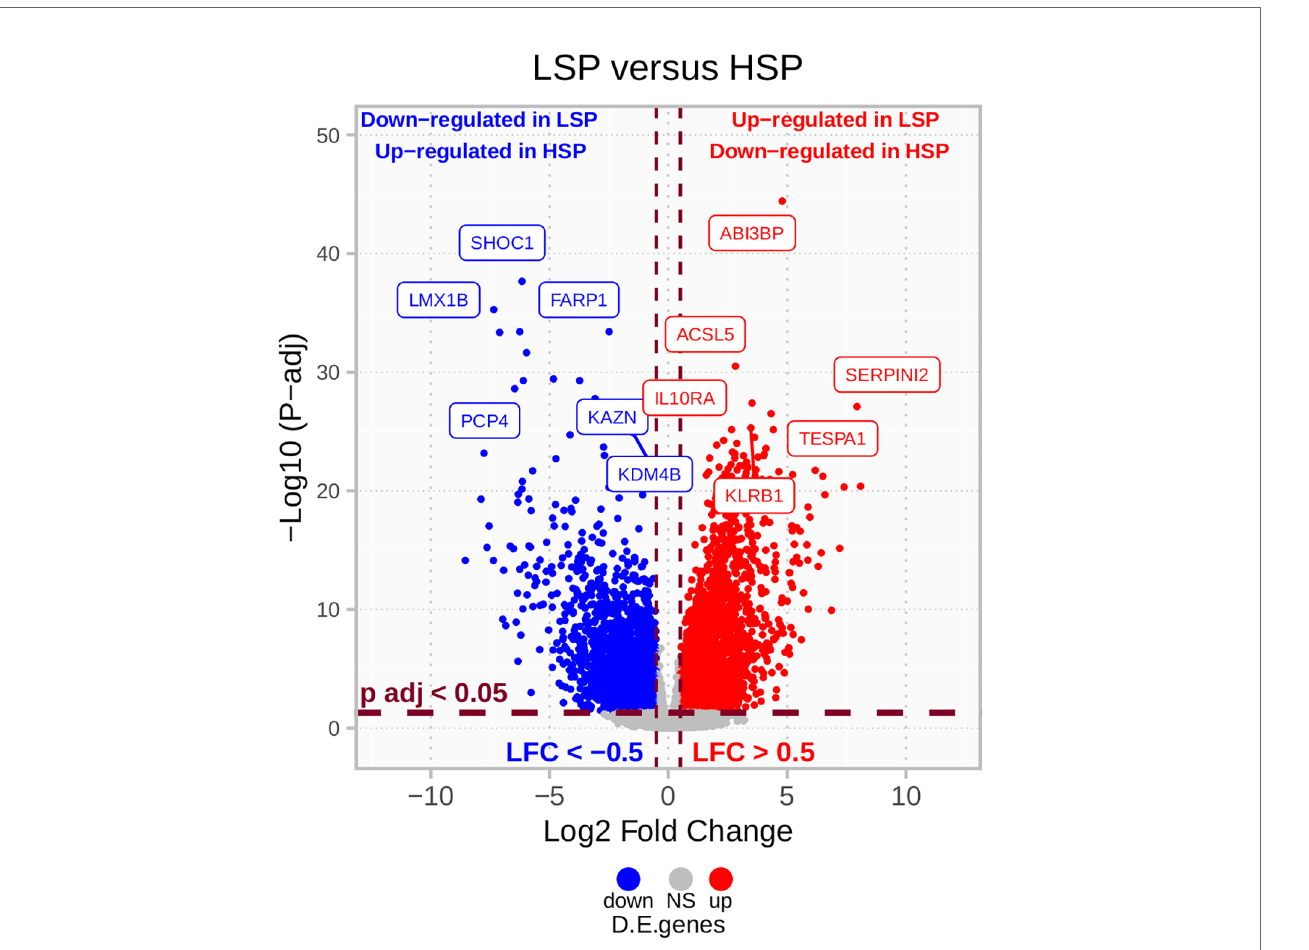
FIGURE 3 | LSP versus HSP DE in TCGA ACC cohort (n = 78). After fi ltering for protein-coding genes and excluding those with sums of zero counts, a total of 19,169 genes were used for a LSP versus HSP differential expression (DE) analysis. P-values were calculated using the Wald ’ s test and adjusted using Benjamini- Hochberg estimation. Genes with absolute log2 fold change lower than 0.5 and adjusted p-value greater than 0.05 are colored in gray. Above these cut-offs, genes upregulated in LSP and downregulated in HSP are indicated in red and genes downregulated in LSP and upregulated in HSP are indicated in